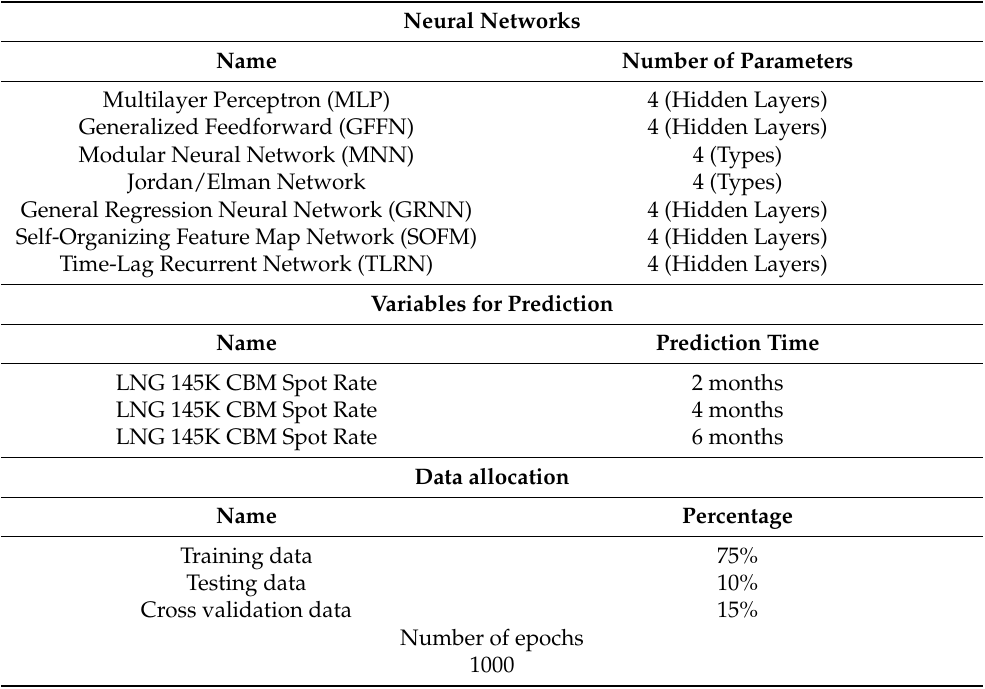
Table 4. Summary of the parameters and the data used in the